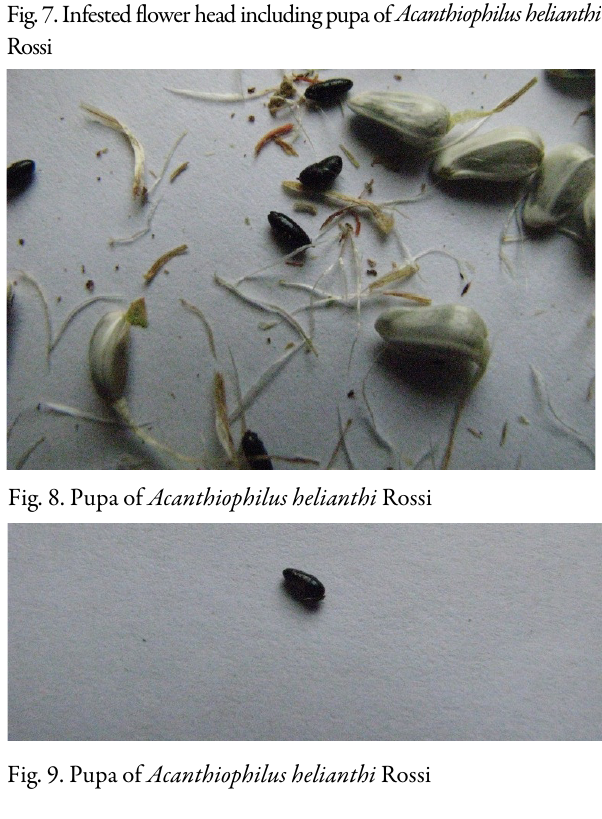
Fig. 9. Pupa of Acanthiophilus helianthi